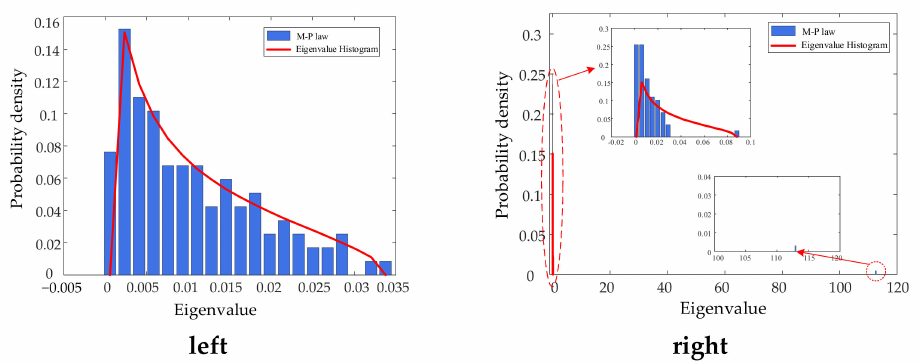
Figure 6. M-P law at stable ( left ) and at fault ( right ).